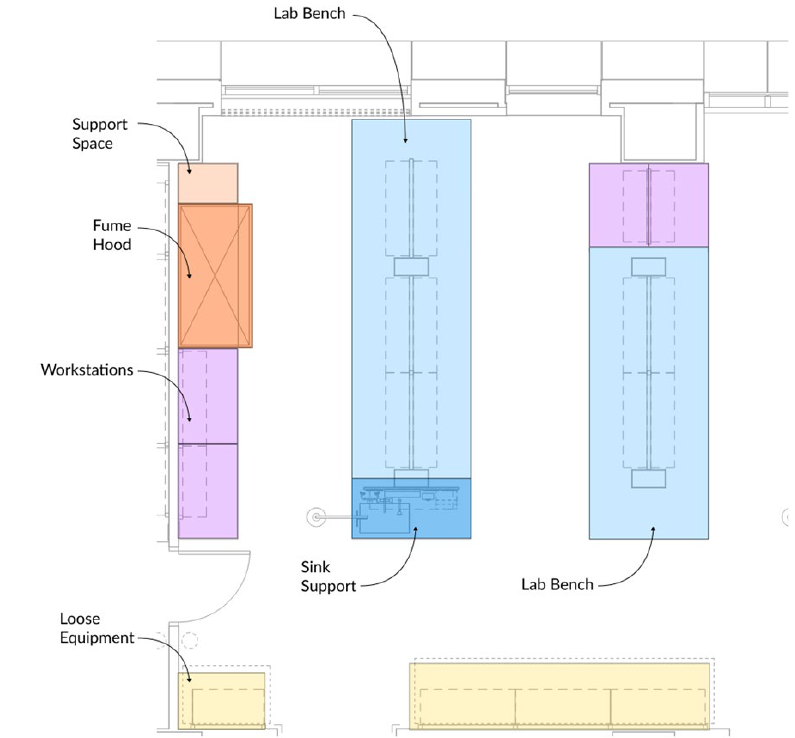
Figure 4. Components of lab modules include benches, equipment, fume hood, and lab workstations (Image copyright: